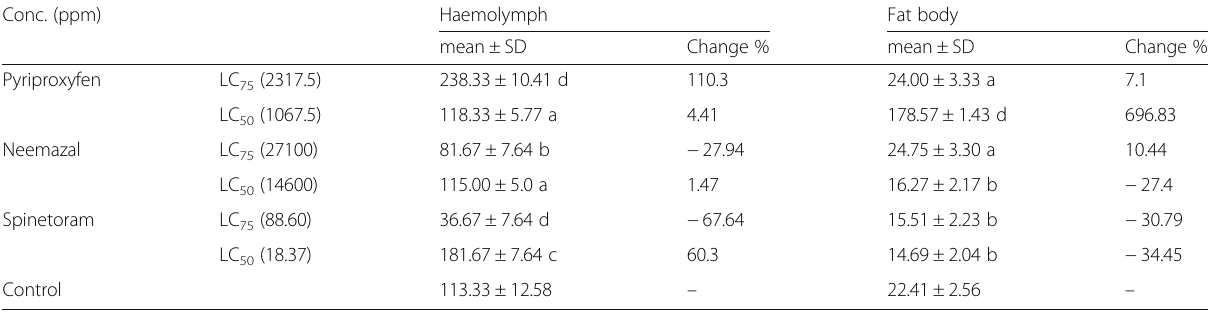
Table 4 GOT activity (U/L) in haemolymph and fat body of the early 5th instar larvae of Rh . ferrugineus after 24-h treatment with LC 50 and LC 75 of the tested insecticidal compounds Conc.